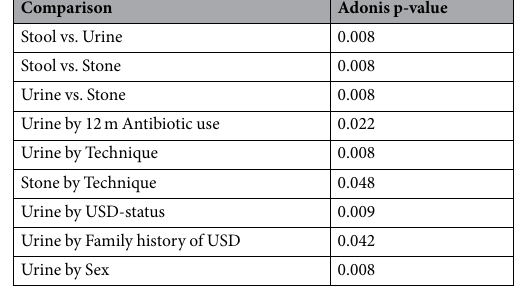
Table 2. List of significant pairwise comparisons of weighted UniFrac beta-diversity. Stool/Urine/ Stone = Specimen that the microbiome data originated from; USD-status = Healthy vs. USD; Technique = Molecular vs. Culture. P-values were corrected for multiple comparisons using a Holm’s